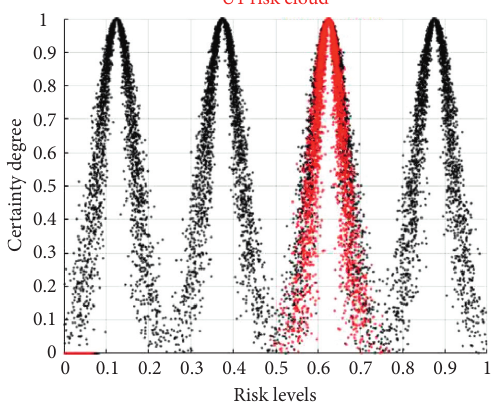
Figure 10: U1 risk cloud